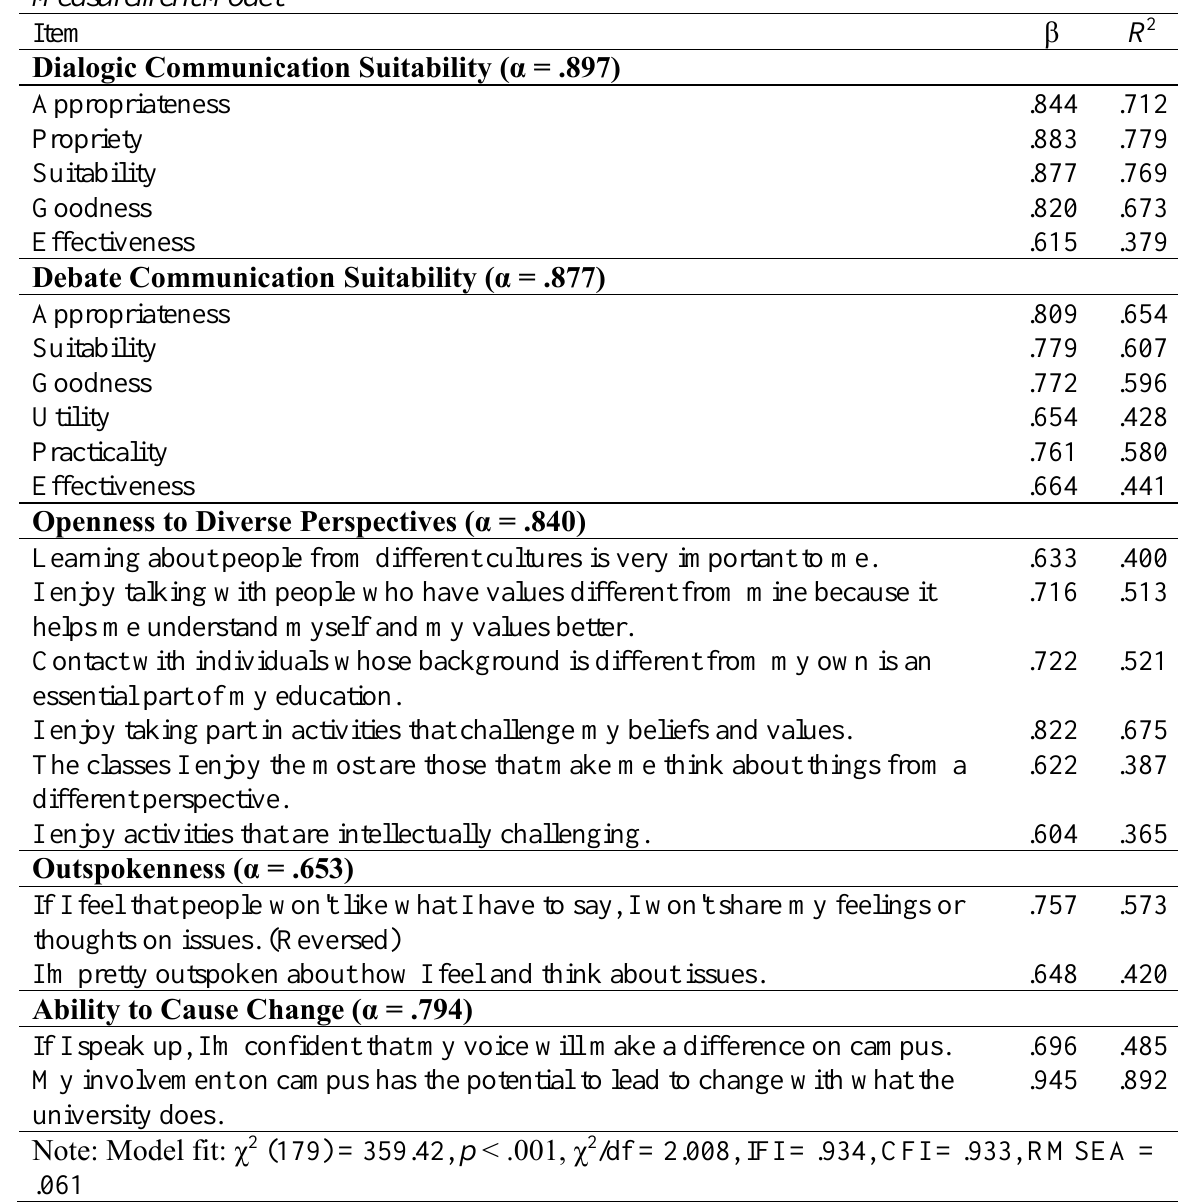
Reliabilities, Item Loadings, Beta Weights, and Squared Multiple Correlations of Final Measurement